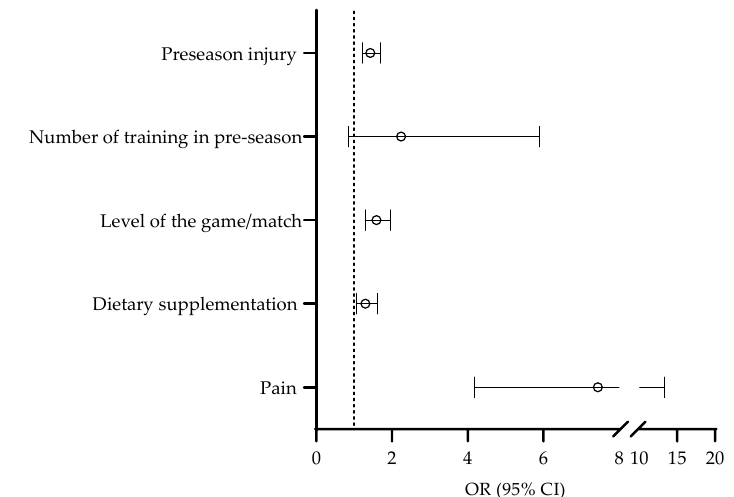
Figure 3. Univariate associations between ( A ) playing positions (with players playing in the last line (Outside backs) as reference value) and ( B ) number of training sessions in a week before the match (with three sessions or more per week as reference value) with injury occurrence.